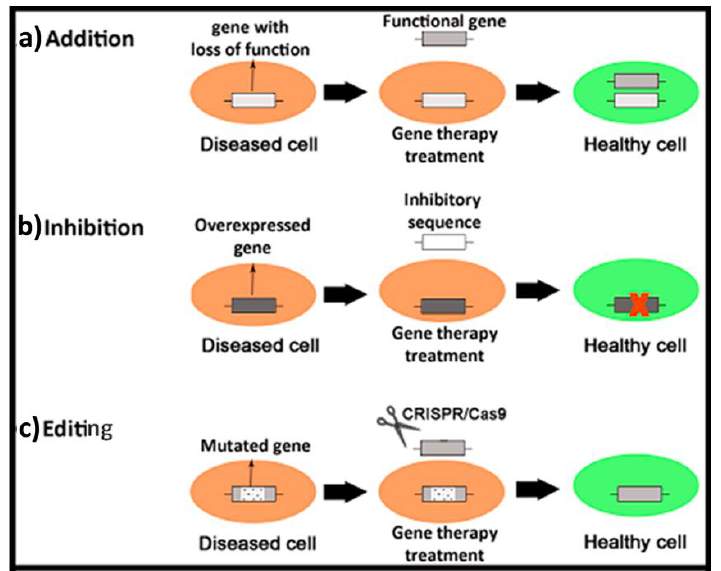
Figure 1. Brief schematic representation of three different genetic material-based approaches to face human diseases. ( a ) Gene addition therapy. ( b ) Gene inhibition therapy. ( c ) Genome editing.